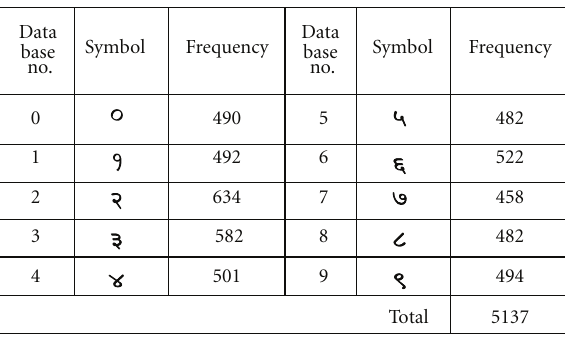
Figure 7: Devnagari Numeral database.